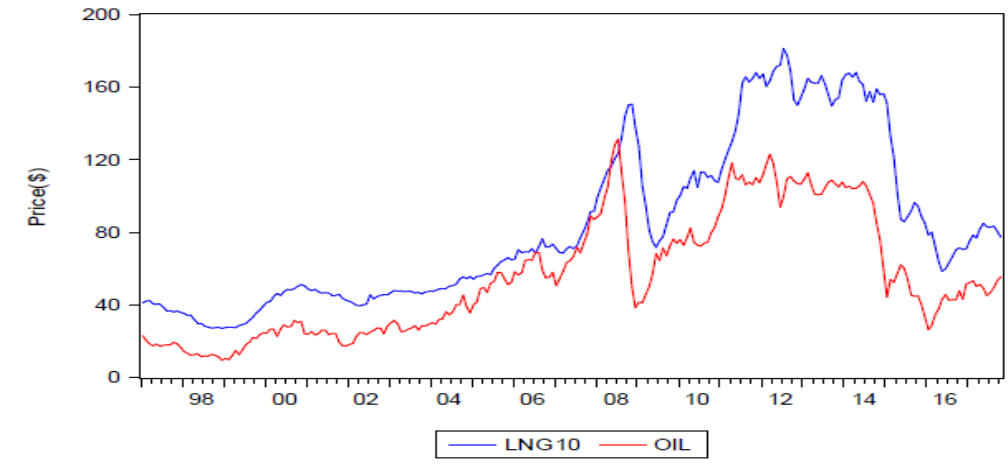
Figure A1: The Trend of Oil and LNG Prices, 1997-2017